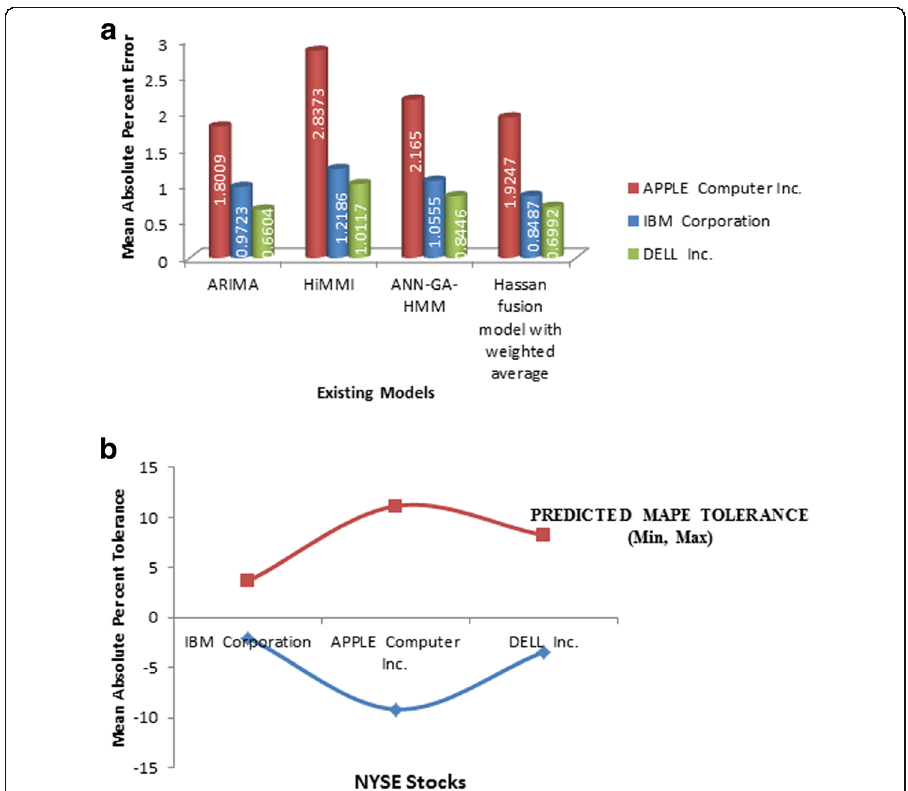
Fig. 4 a Existing methods of Hassan, showing MAPE tolerance for dataset of various stocks b Outcome of the current jump analysis method showing MAPE tolerance for dataset of various stocks studied by